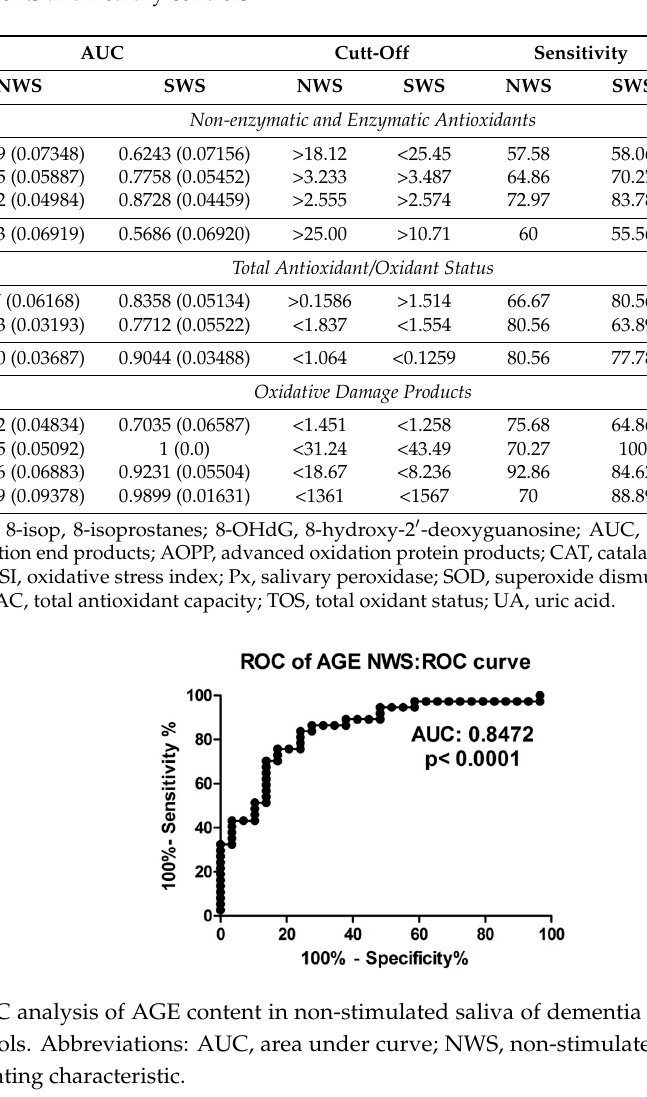
Table 4. Receiver operating characteristic (ROC) analysis of salivary markers of oxidative stress in dementia patients and healthy controls.